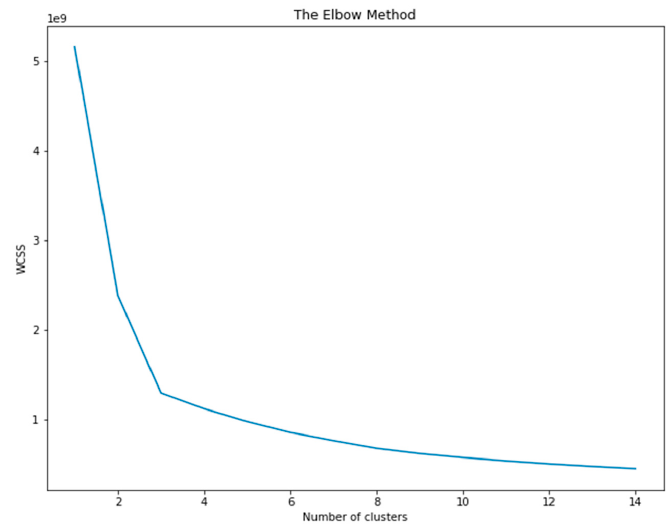
Figure 7. Elbow method used during the clustering problem to test the different numbers of clusters. Table 9. Silhouette Coefficient obtained for different number of clusters applied to one single HVAC subsystem.